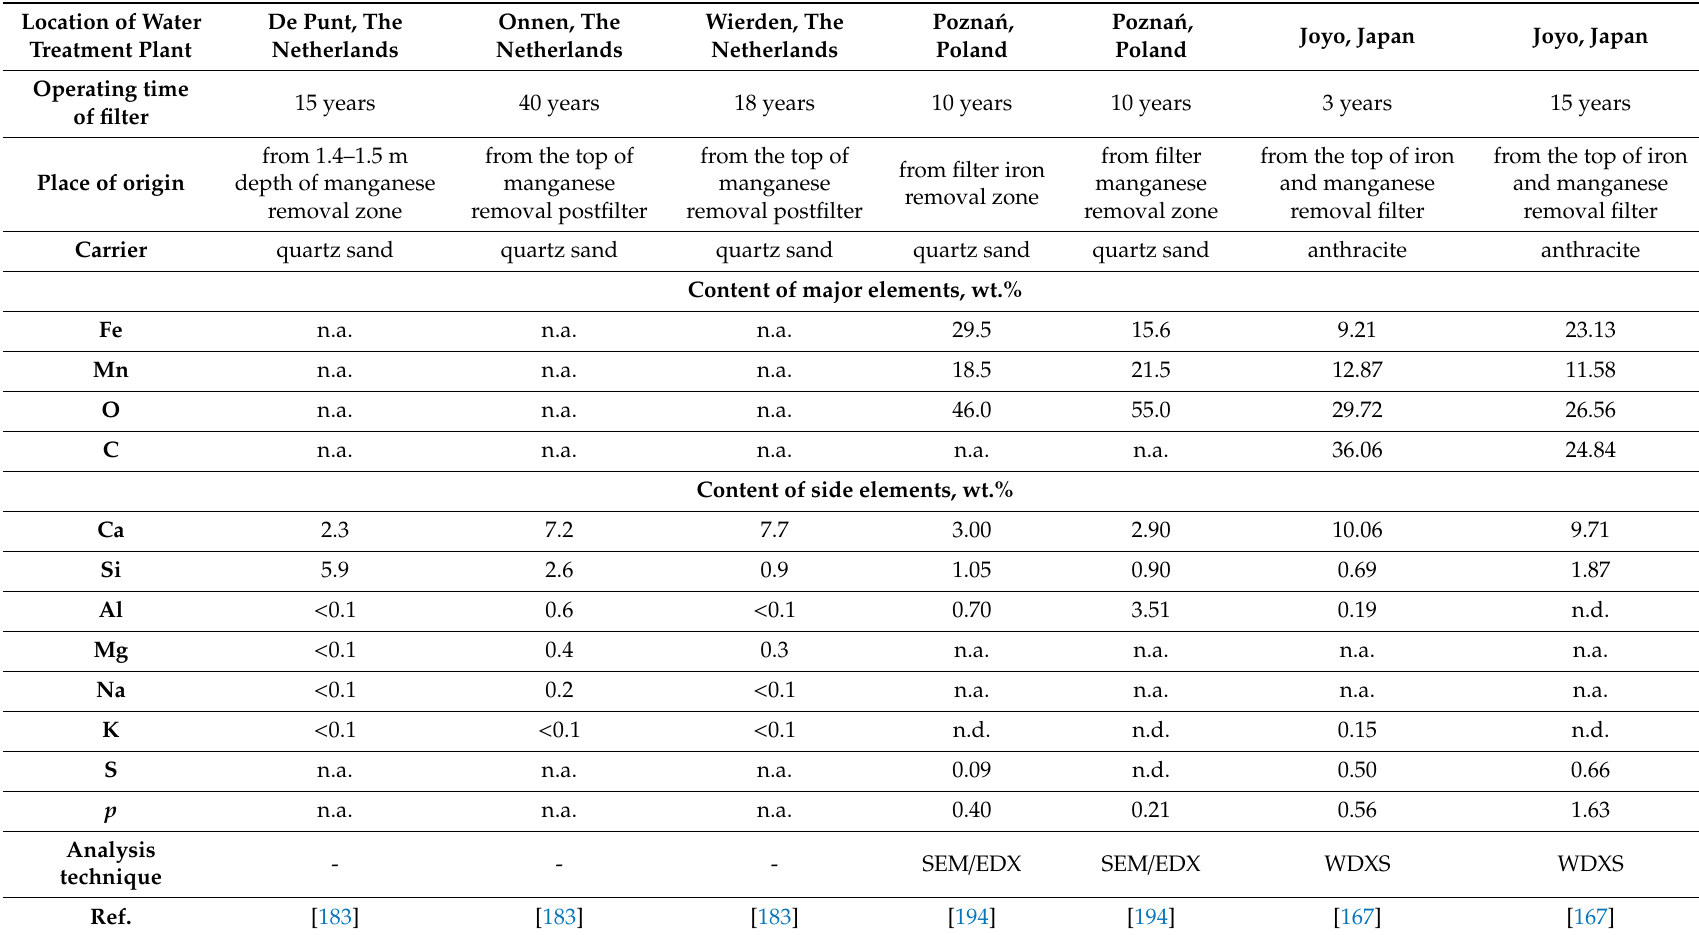
Table 6. The elemental composition of the surfaces of naturally coated filter